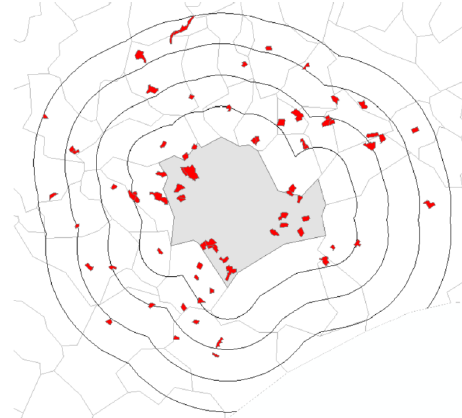
Figure 1. Land-use cartography on the area of Montpellier in 2017, extracted from Sentinel-2 satellite images (source: CES OSO). Figure 2. Land-use changes observed between 2006 and 2012 around the city of Montpellier (France) in the Corine Land Cover